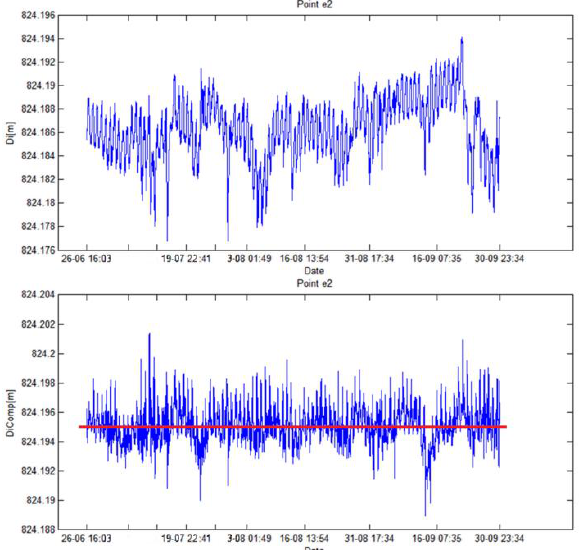
Figure 11. Raw and corrected values of distance for point e2 (on a building)